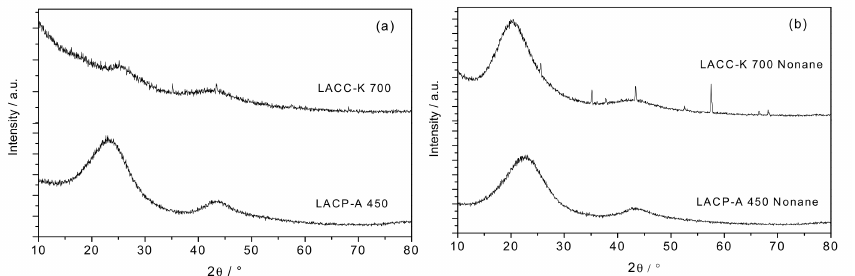
Figure 1. X-ray di ff raction (XRD) profiles for the lignocellulosic-based activated carbons ( a ) before and ( b ) after adsorption of